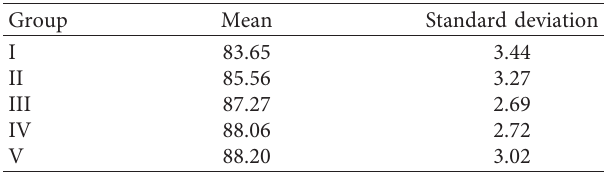
Table 9: Statistical results of Mann–Whitney U Test. Group pair Z − Z ( Groups I and II −